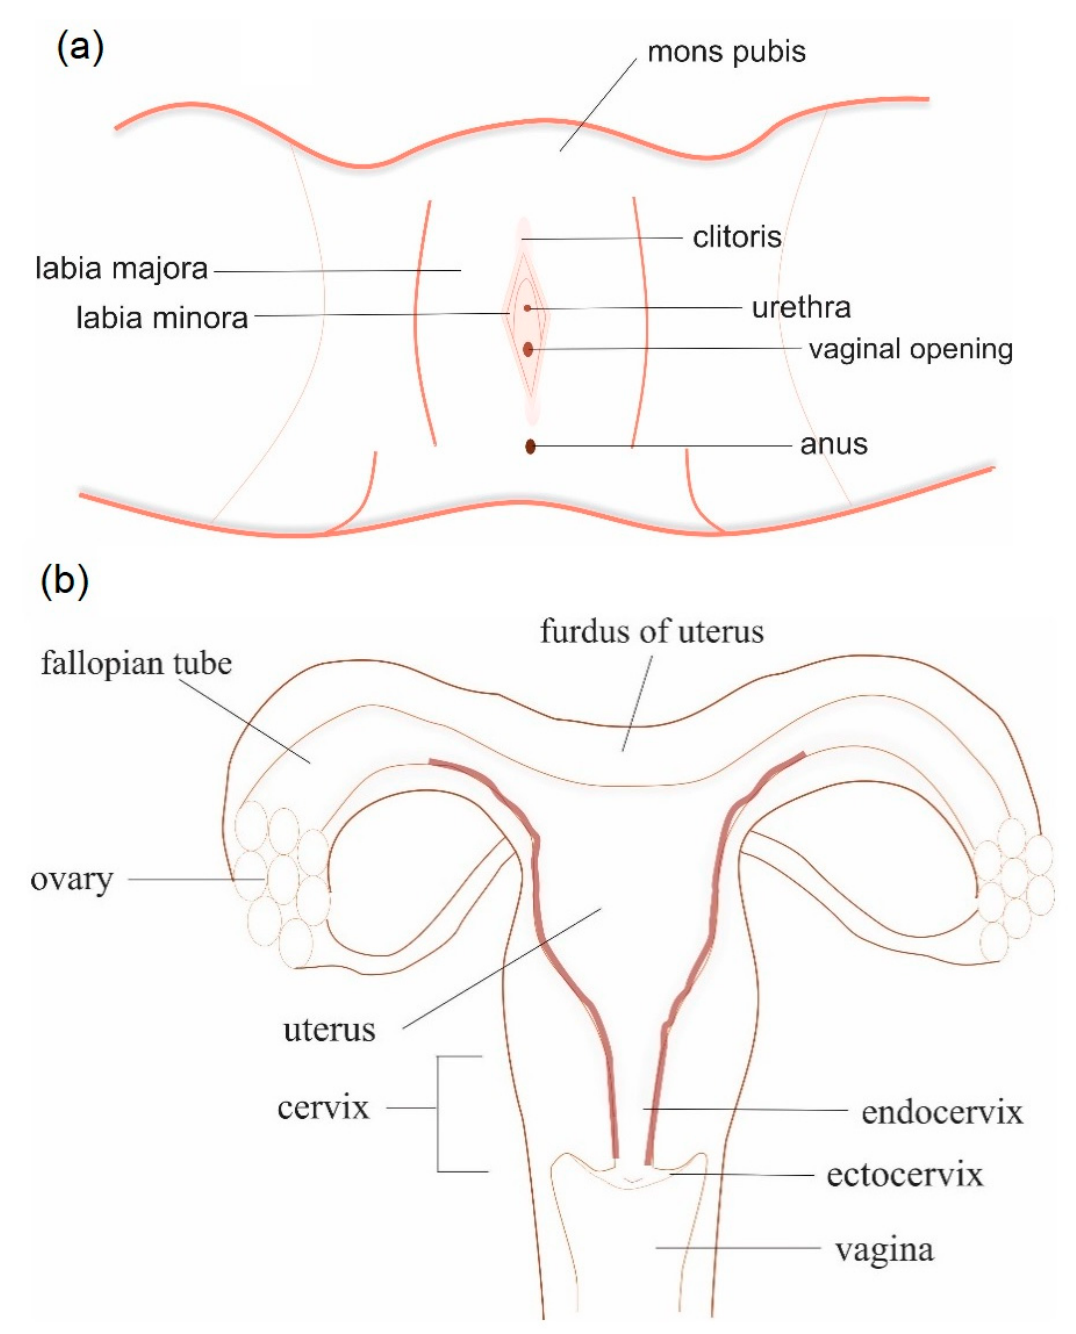
and the chemical changes such as pH, vaginal fluids, and vaginal mucus [12,14,15]. This poses a challenge for the development of vaginal products.